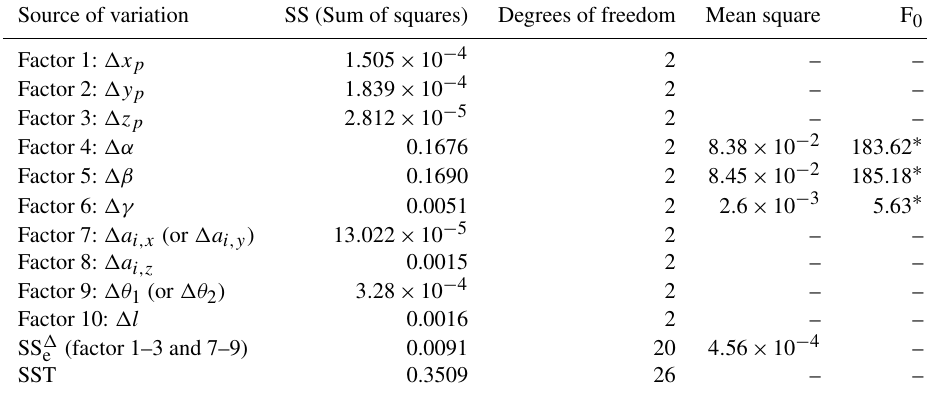
Table 7. Variance analysis for the sensitivities of the tolerance factors. Source of variation SS (Sum of squares)